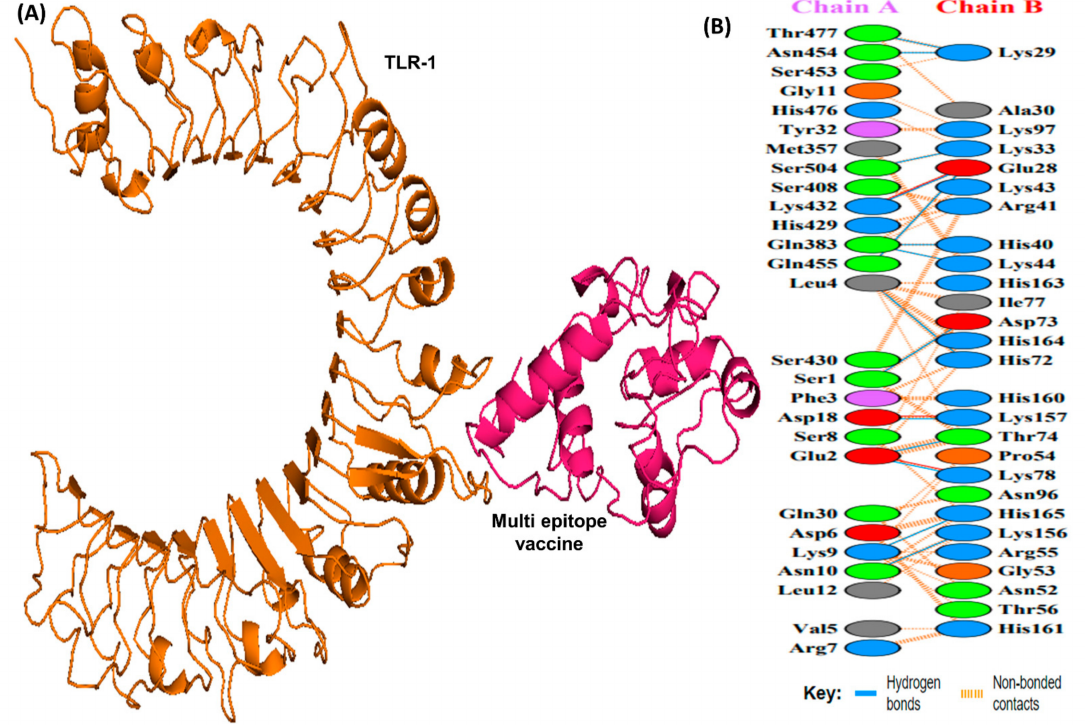
Figure 6. A schematic depicting the docked complex of TLR-1 and vaccine and residue interactions. ( A ) The TLR-1 receptor is shown in orange and the vaccine (in hot pink) is attached to it. ( B ) Interface residue interaction. There are 14 hydrogen bonds depicted in blue lines. Residues are shown in multiple colors to show their properties e.g positive (blue); negative (red); neutral (orange); aliphatic (gray); aromatic